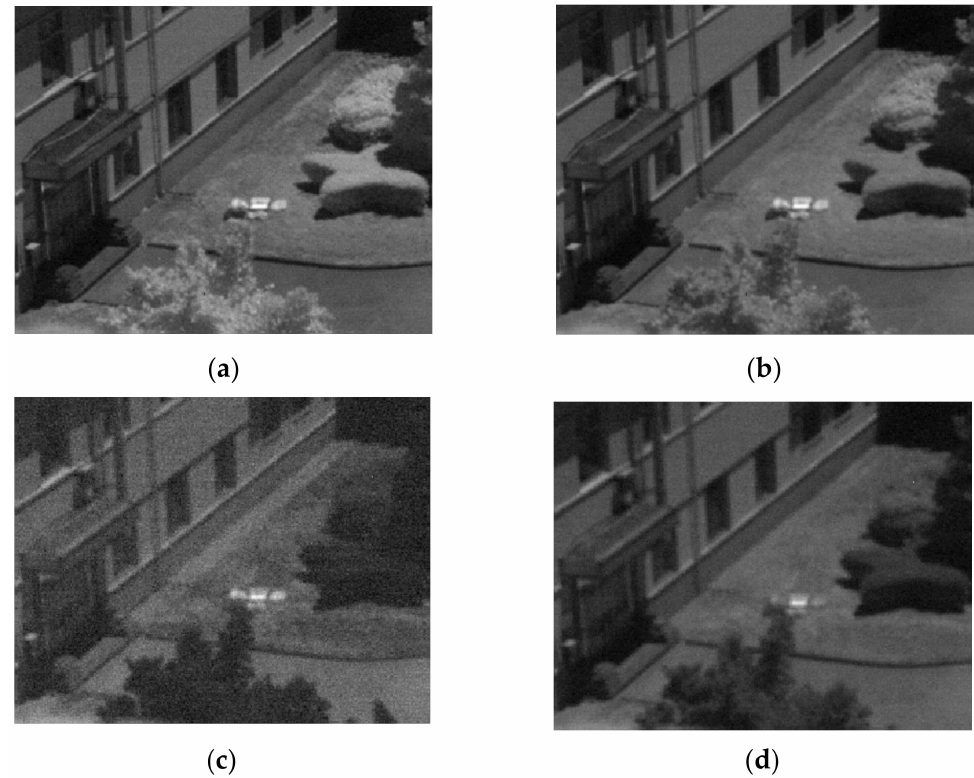
Figure 5. Single band grayscale images at different wavelengths. ( a ) Single band grayscale images at 1050 nm. ( b ) Single band grayscale images at 1250 nm. ( c ) Single band grayscale at 1570 nm. ( d ) Single band grayscale at 1650